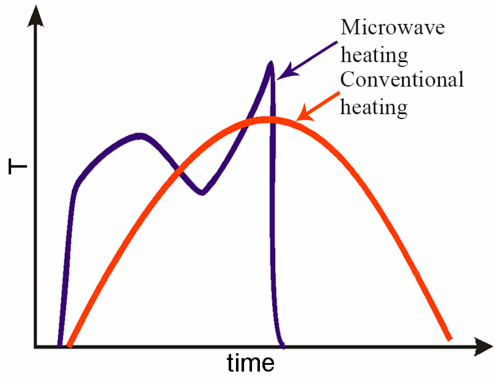
Figure 4. Schematic presentation of the thermal microwave effects as variation of temperature in